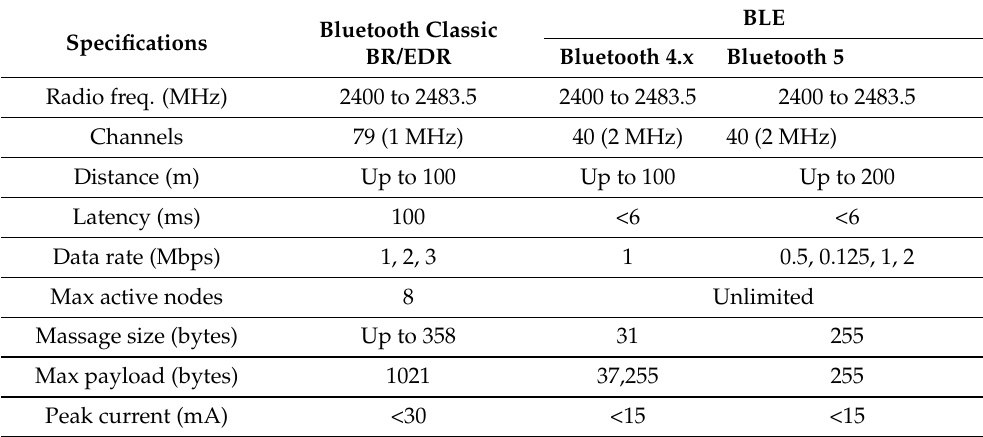
Table 1. Comparison of Bluetooth